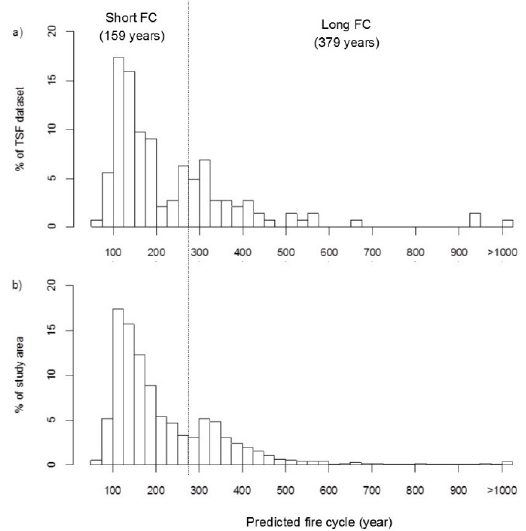
Figure 6. Predicted fire cycle (FC) (years) distribution according to the model detailed in Table 4 for ( a ) the TSF dataset ( n = 144) and ( b ) the whole study area. The dotted line shows the division between short and long FC zones estimated with the whole study area (b). FC for each zone is calculated using the TSF dataset (see Table 5 for details).